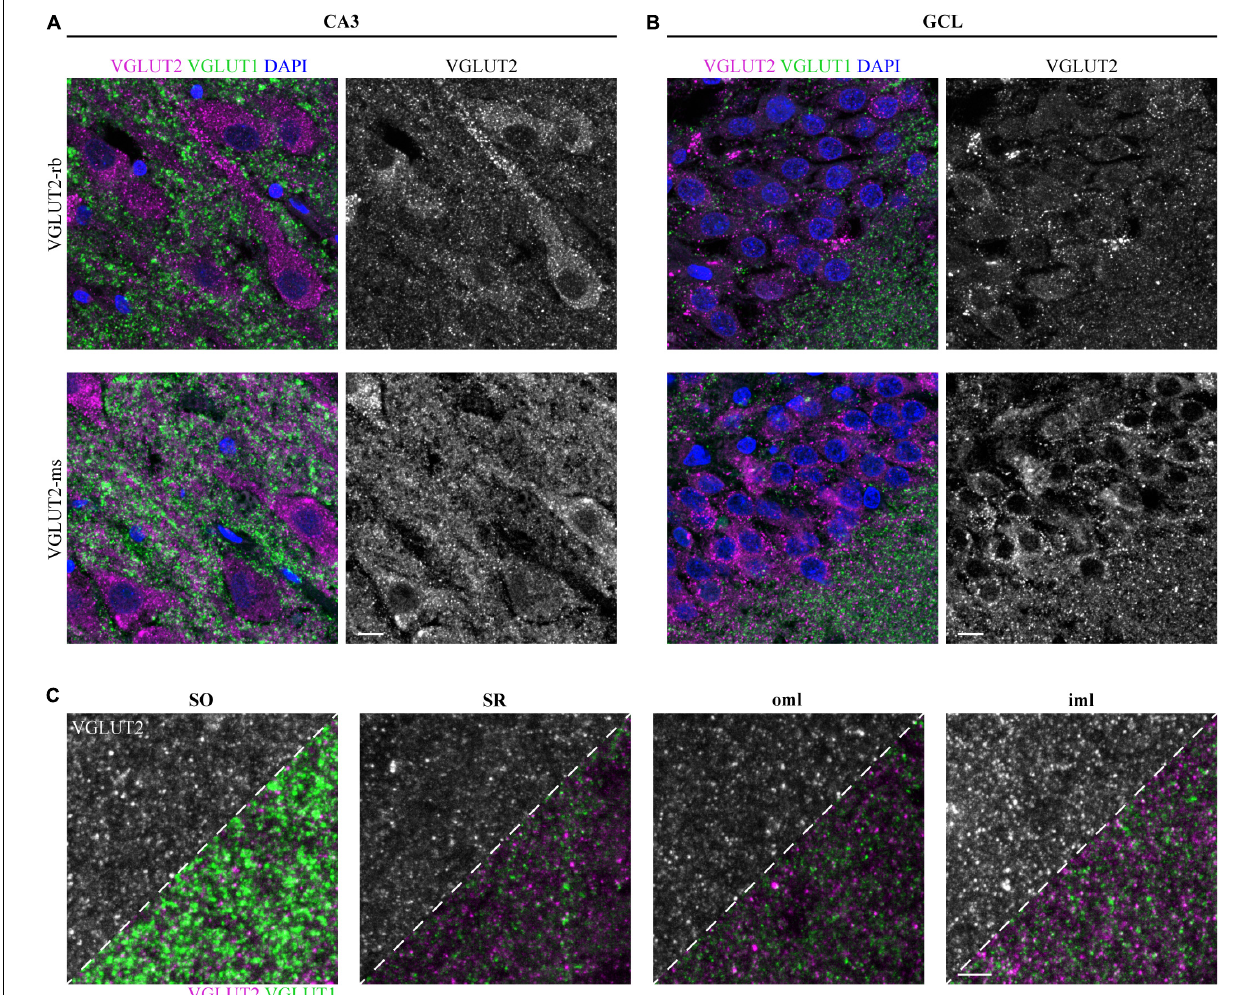
FIGURE 4 | Detectable VGLUT2 immunofluorescence in the human hippocampus. (A) Immunofluorescence staining with VGLUT2 (magenta) and VGLUT1 (green) in the SP of CA3 is represented as overlay (left) and separately for VGLUT2 (gray, right). Staining results obtained with two different VGLUT2 antibodies are opposed, one antibody was raised in rabbit (upper row), the second one was raised in mouse (lower row). Images represent MIPs of high-resolution z-stacks (z = 1.98 µ m), imaging parameters and contrast adjustments were kept constant per antibody. (B) In the same manner as explained in panel (A) , immuno-reactivity for the GCL is displayed. Scale bars (A,B) , 10 µ m. (C) Rabbit anti-VGLUT2 immunofluorescence in the SO, SR, oml, and iml. Acquired images are shown in a dual fashion; the upper left corner solely shows the VGLUT2 channel, for the lower right corner, the VGLUT1 channel was overlaid. Images represent MIPs of z-stacks (z = 1.98 µ m) and imaging parameters as well as contrast adjustments are constant per antibody. Co-staining did not reveal co-localizing puncta, arguing for specific labeling of both proteins. Scale bar, 5 µ m. Images in panels (A,B) are derived from case 1, (C) represents case